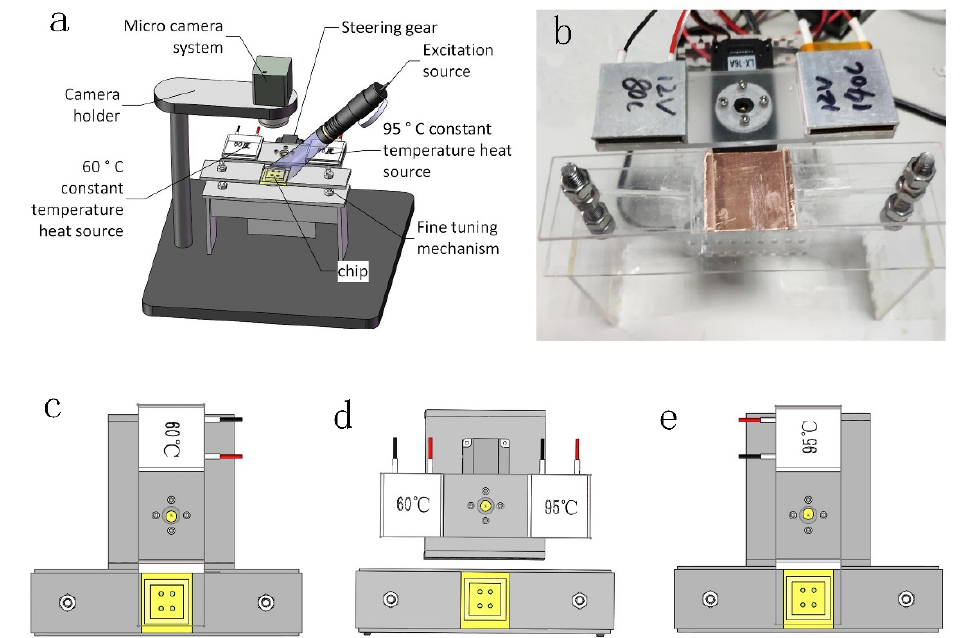
Figure 1. ( a ) Structural drawing of the battery-operated portable qPCR system. ( b ) Close-up of the chip holder. ( c ) Configuration for the ( c ) 95 °C heating, ( d ) air cooling, and ( e ) 60 °C cooling with a constant temperature.